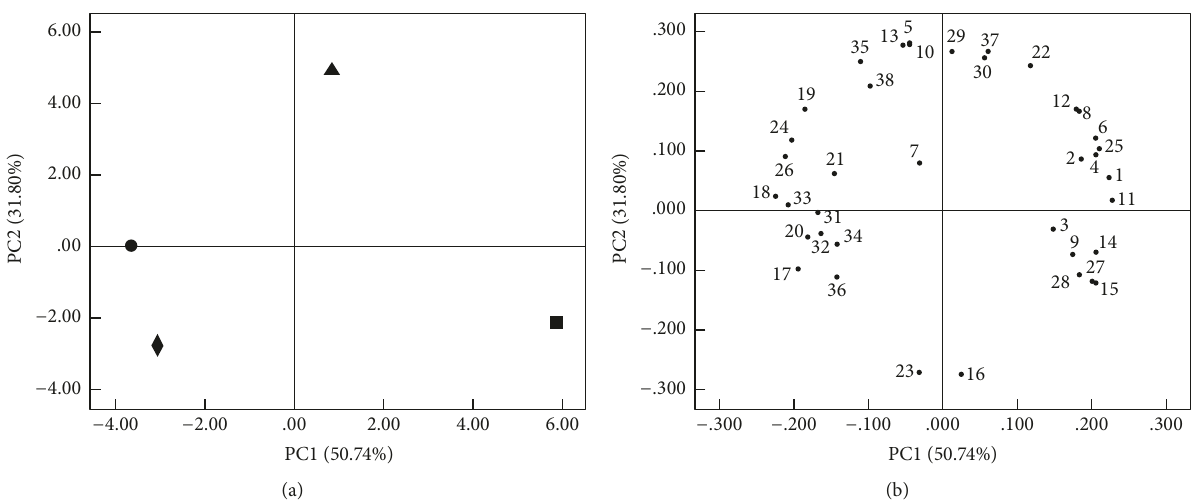
Figure 2: Biplot of principal component analysis of hawthorn wines. (a) Wine from the extracted juice with pectase ( e ); wine from the extracted juice without pectase ( ⧫ ); wine from nonextracted pulpy juice with pectase ( 󳵳 ); wine from nonextracted pulpy juice without pectase